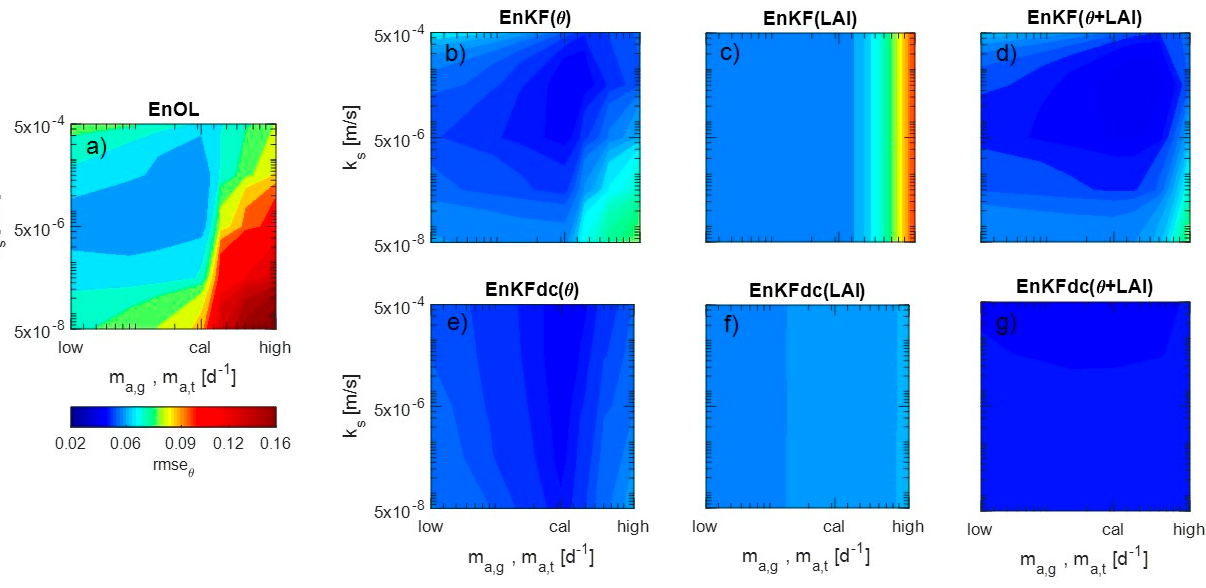
Figure 5. The root mean square error (rmse) of soil moisture ( θ ) predictions using the ( a ) EnOL, EnKF, and EnKFdc approaches with the assimilation of the radar backscatter (related to θ ) only ( b , e ), the assimilation of grass and tree NDVI (related to LAI) only ( c , f ), and the assimilation of both radar backscatter and grass and tree NDVI ( d , g ), while varying the initial ˆ m a , g , ˆ m a , t , and ˆ k s values (low m a,g and m a,t values correspond to 0.0032 d − 1 and 0.0001 d − 1 , respectively, while high m a,g and m a,t values correspond to 0.12 d − 1 and 0.01 d − 1 , respectively; cal—calibrated values of Table 3).